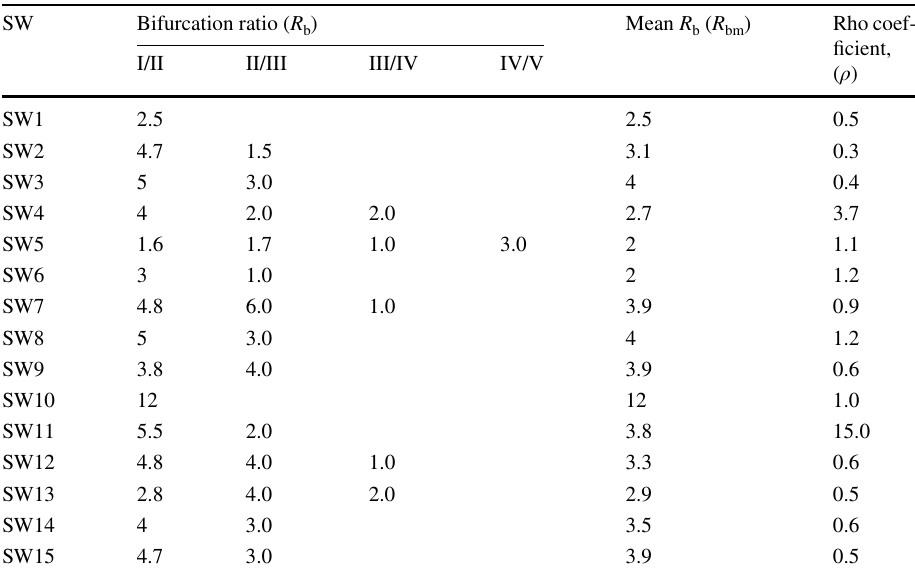
Table 3 Bifurcation ratio, mean bifurcation ratio and Rho coefficient